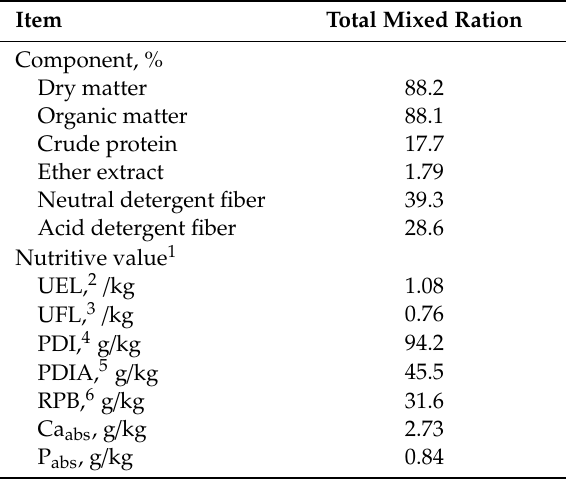
Table 1. Chemical composition and nutritive value of the ration expressed on dry matter (DM)